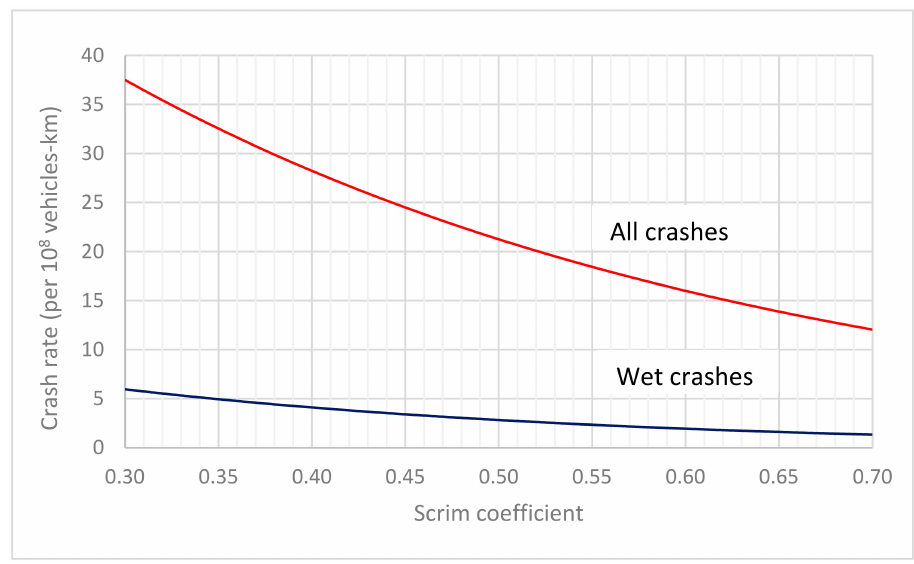
Figure 3. Sideway-force Coefficient Routine Investigation Machine (Scrim) coefficient vs. crash rate (adapted from [22]).